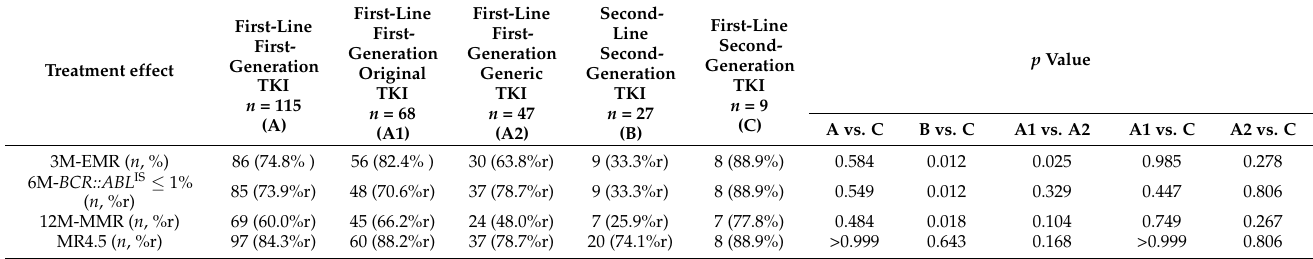
Table 5. Analysis of TKI therapies on the molecular response of 151 CML-CP patients.